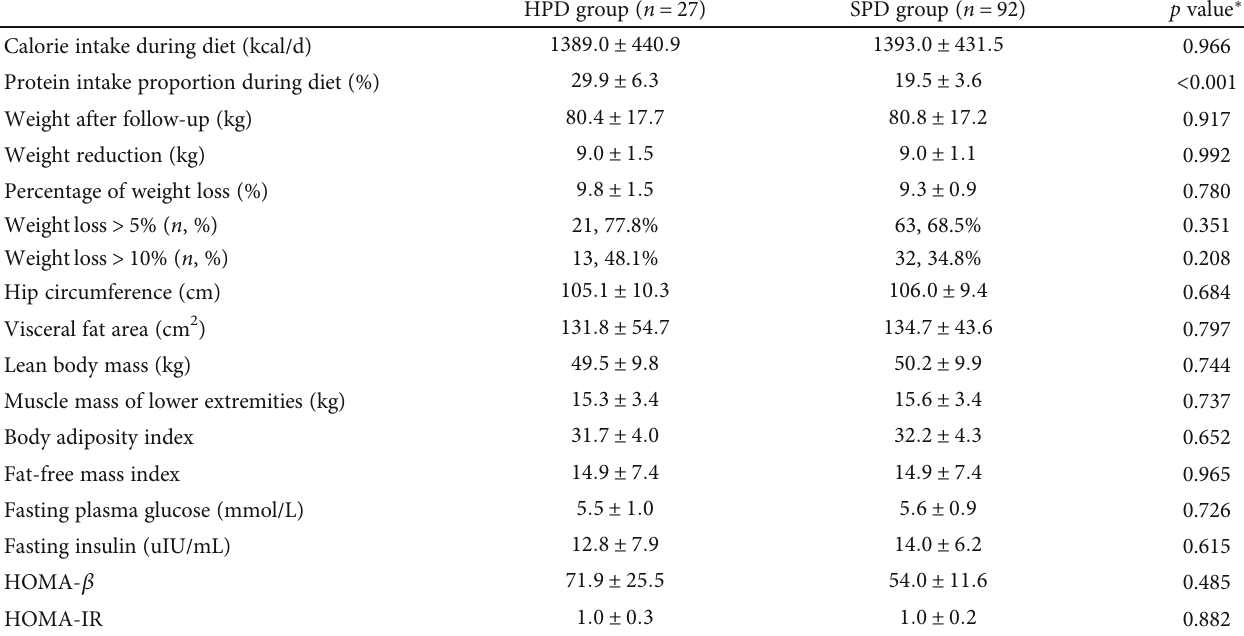
Table 3: Comparison of diet, anthropometric and biochemical variables between SPD and HPD group after treatment of obesity MDT. HPD group ( n = 27 ) SPD group ( n = 92 ) p value ∗ Calorie intake during diet